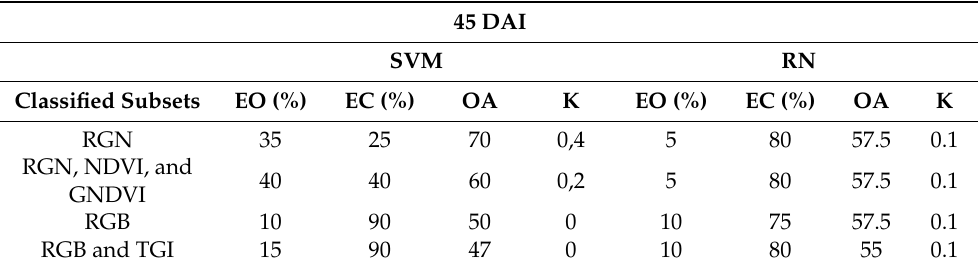
Table 5. Supervised classification of coffee seedlings inoculated and non-inoculated by H. vastatrix , at 45 days after inoculation (DAI), and omission errors (EO), commission error (EC), global accuracy (AG) and Kappa index